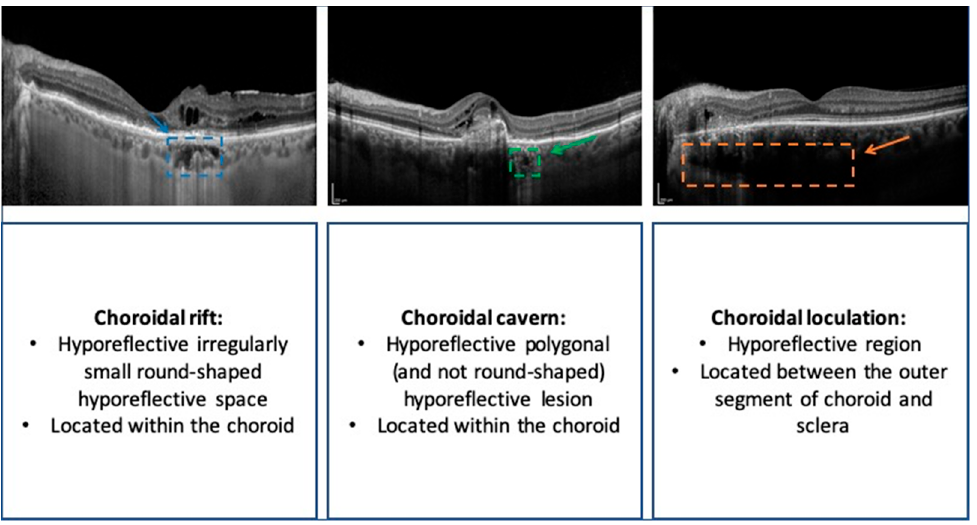
Figure 3. Schematic representation of the different choroidal findings that may be seen in patients with chronic